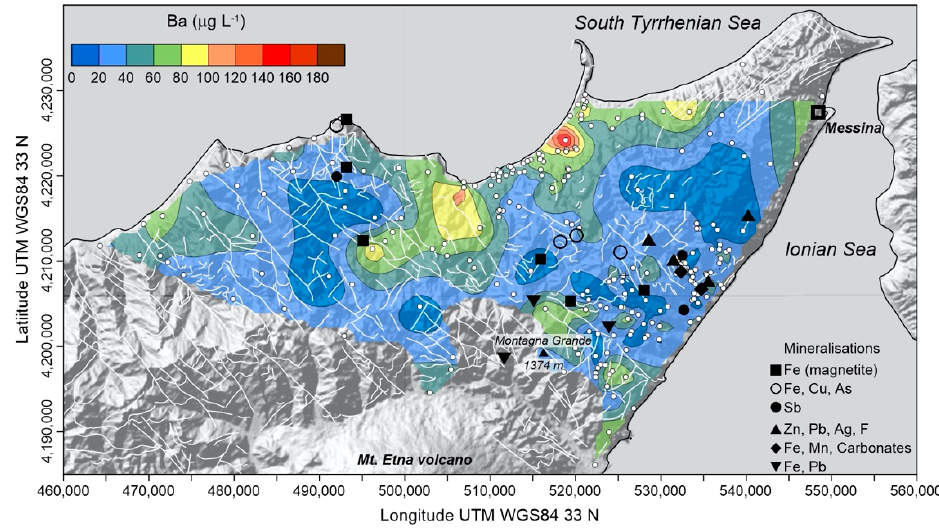
Figure 13. Concentration distribution map of Ba, reporting locations of sampling points (with indication of those exceeding the related MACs) and main mineral deposits; tectonic lineaments (white lines) are also illustrated.